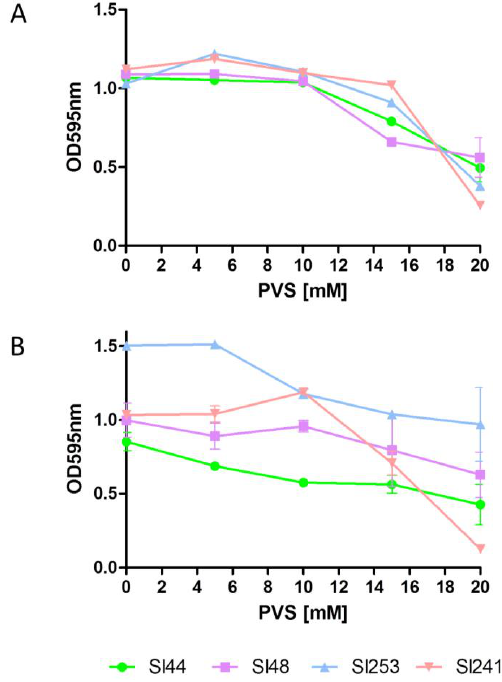
Figure 9. Effect of hydroxylamine HCl on binding of S. lugdunensis wild type strains to Fn ( A ) or Fg ( B ) coated wells. Overnight cultures were diluted to an OD 595 of 0.01. 180 µ L of diluted culture were mixed with 20 µ L of concentrated hydroxylamine hydrochloride to the respective concentrations in a microtiter plate well. Plates were incubated at room temperature for 1 h. Adherence was determined in a Biorad reader at absorbance of 595 nm. Data are presented as mean adsorptions of triplicate determinations. Single representative experiments out of three are presented. Error bars show standard deviations (SD).